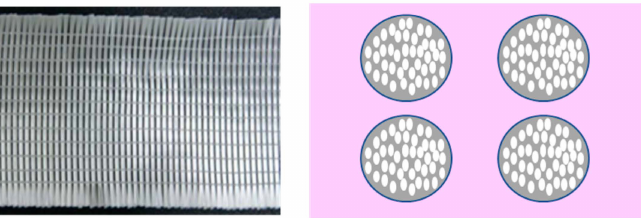
Figure 4. Tow illustrations with many single fiber filaments for the double-scale porous media.